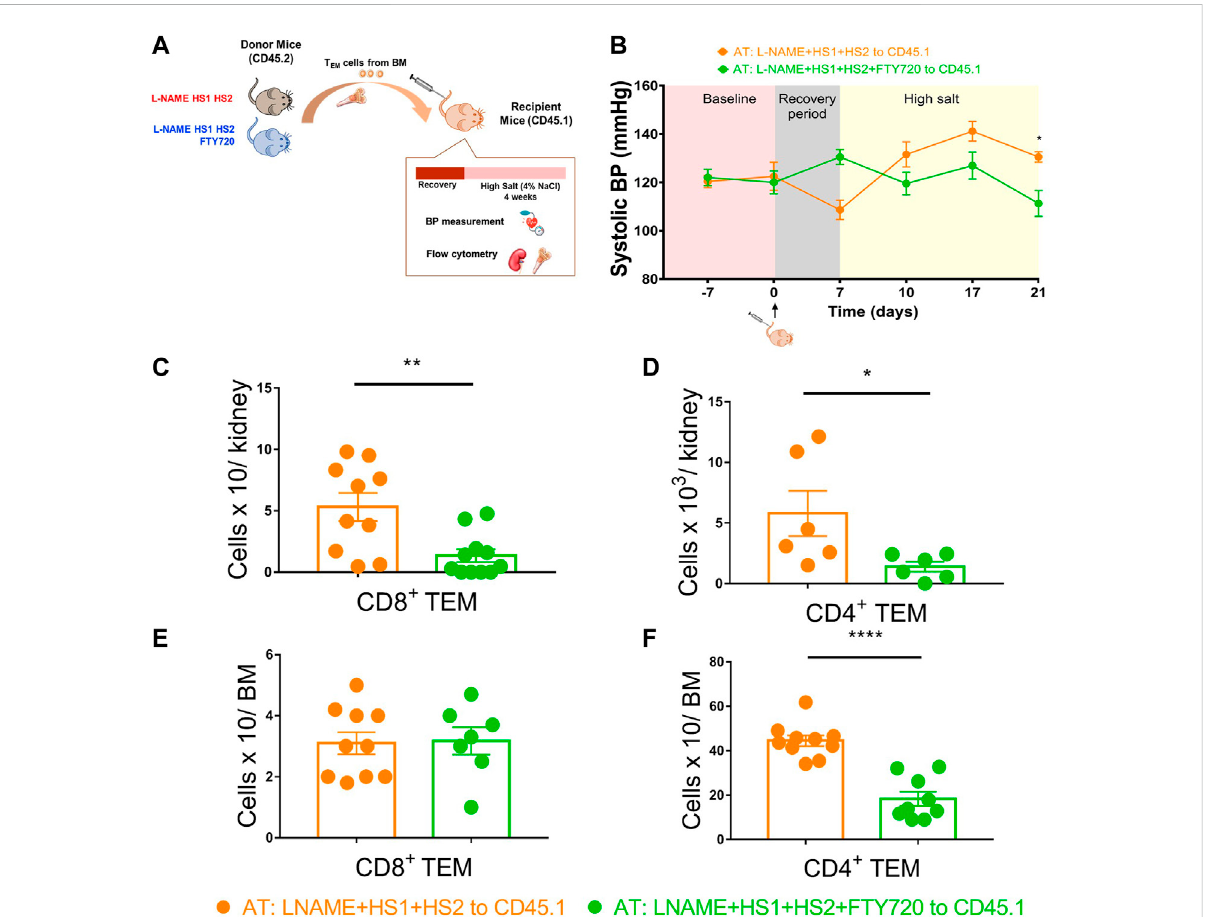
FIGURE 5 Fingolimod inhibits the recirculation and redistribution of T EM cells into the kidney in response to moderate hypertensive stimulation. (A) Experimentalparadigm: Summary oftheprotocolfollowedto studytheeffectof fi ngolimodontherecirculation andredistributionofTEMcellsafter a moderate hypertensive stimulus. Bone marrow TEM cells from donor CD45.2 WT mice received L-NAME + HS1+HS2± fi ngolimod were adoptively transferred to recipient CD45.1 mice. Recipient mice were then fed a high salt diet for 3 weeks (N = per group) (B) Tail-cuff systolic blood pressure measurements wererecordedthroughoutthe whole protocol starting from thebaseline(beforeadoptivetransfer) and reaching theend of the3 weeks ofhighsalt feeding. (C – F) After asuccessful AT,thelevelsofthetransferredCD8 + andCD4 + TEMcellsweremeasuredinthekidney